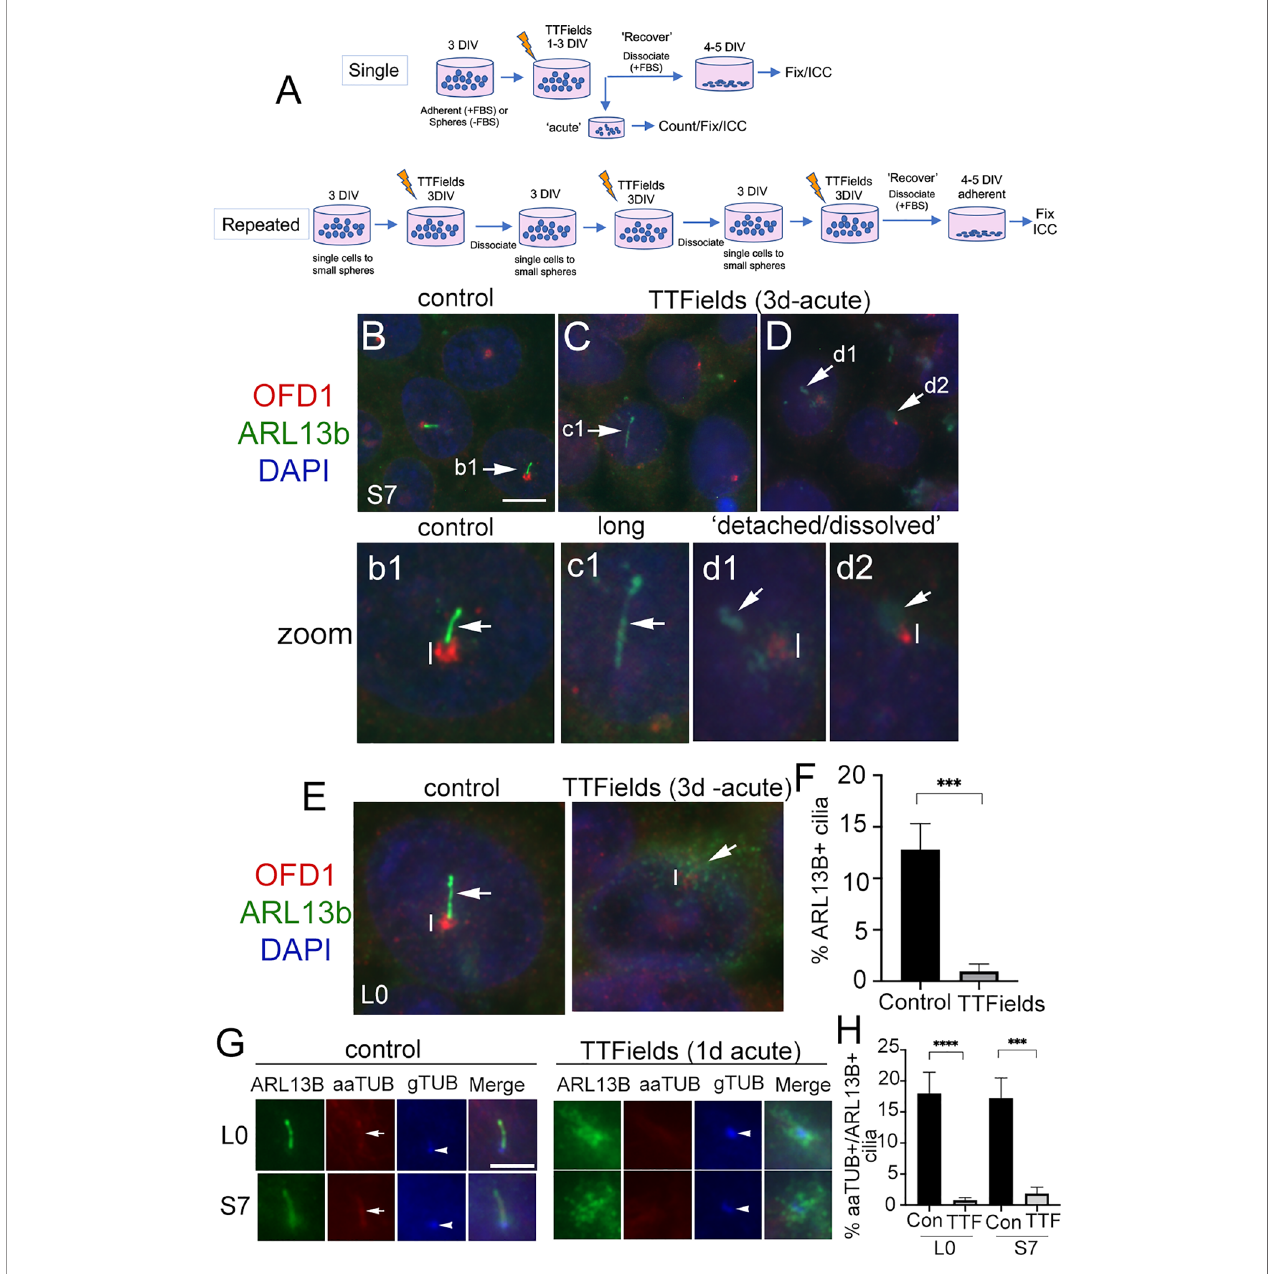
FIGURE 1 | Primary cilia on patient-derived glioma cells are ablated by TTFields. (A) General approach to treat cells with a single or repeated exposure to TTFields in vitro . Cells that were grown adherent on glass coverslips had media supplemented with 10% fetal bovine serum (FBS). (B – D) S7 control cells stained for OFD1 (red), which clusters around basal bodies/centrioles, and ARL13B (green) which are enriched in the primary cilium. Nuclei are labeled with DAPI (blue). In control (B) , ARL13B + cilia (arrow in b1 zoom) from OFD1 + puncta (vertical line). In S7 TTFields-treated cells (C, D) , ARL13B + cilia appeared elongated (e.g., c1 ), detached, or separated away from the OFD1 + basal body (e.g., d1 ) or somewhat dissolved or cloudy in appearance at OFD1 clusters (e.g., d2 ). OFD1 clusters in TTFields-treated cells appeared smaller/less intense compared with control (compare vertical lines between b1 and d1 / d2 ). (E) Control or 3 days of TTFields-treated L0 cells stained similar to (B) . Control cells display clear OFD1+ basal body (vertical line) at the base of ARL13B + cilia (arrow). TTFields-treated cells displayed less intensely labeled OFD1 + basal body (vertical line) with surrounding dispersed/cloudy puncta of ARL13B (arrow). (F) Percent of ARL13B + cilia in L0 cells in control vs. TTFields. (G) L0 (upper row) and S7 (bottom row) cells stained for ARL13B (green), acetylated alpha tubulin (aaTUB, red), and gamma-tubulin (gTUB, blue). Control cells show ARL13B+ cilia colocalized with aaTUB (arrow) with gTUB + basal bodies (arrowheads). TTFields-treated cells have clustered/dispersed ARL13B signal with no clear aaTUB + axoneme associated with the gTUB + basal body. (H) Percent of aaTUB + /ARL13B + cilia in control or TTFields-treated L0 and S7 cells. *** p < 0.001, **** p < 0.0001 (ANOVA). Scale bars (in µm) = 10 (B) and 5 (G)